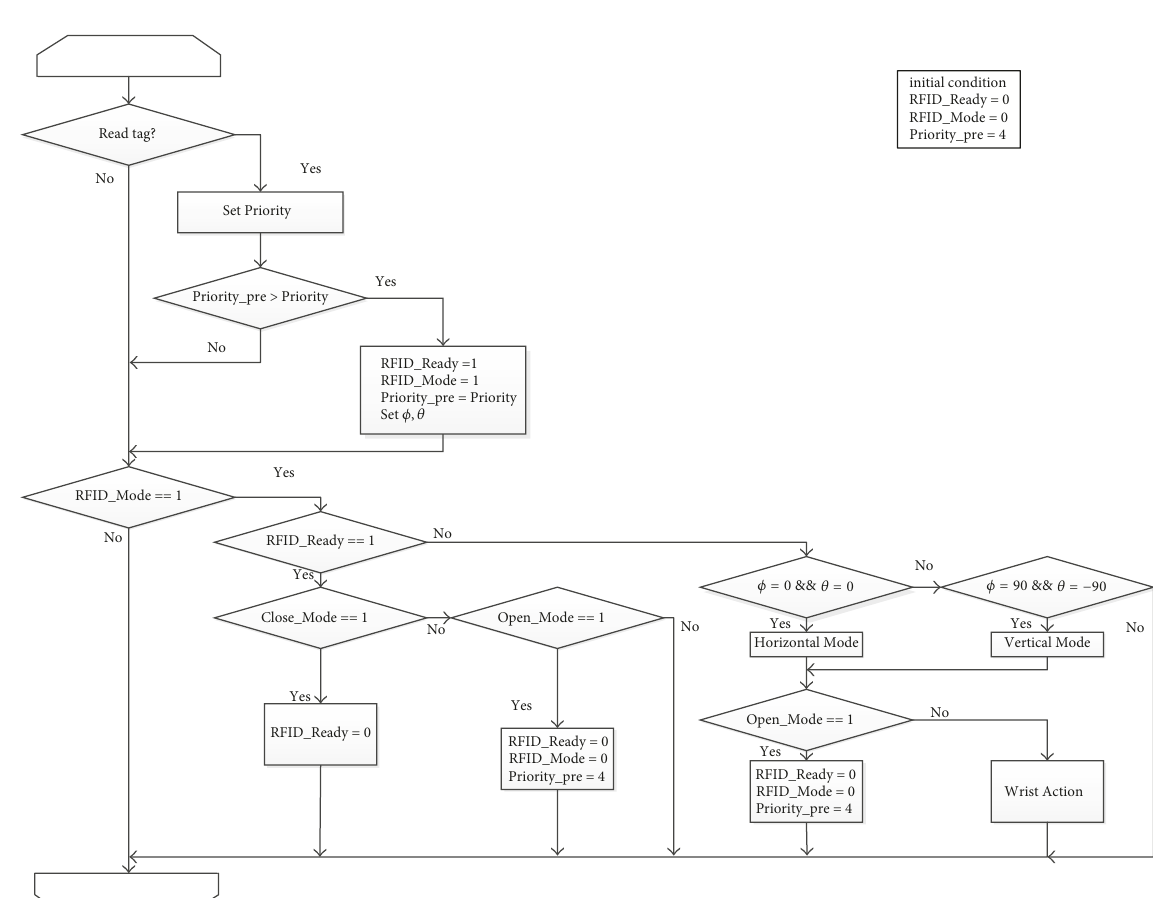
Figure 5: Flowchart of the wrist action. When RFID tag information is received and the priority of the tag information is higher than the previous value, the hand posture is set based on the tag information. The priority is set with 2 bits, and the smaller the number, the higher the priority. After the wrist joint angles (pronation/supination and flexion/extension angles) are determined based on the tag information ( 𝜙 : roll angle of the hand; 𝜃 : pitch angle of the hand), the work plane posture, and the upper limb posture, the wrist joint starts action when Close Mode is set and it stops the operation of the wrist joint when Open Mode is